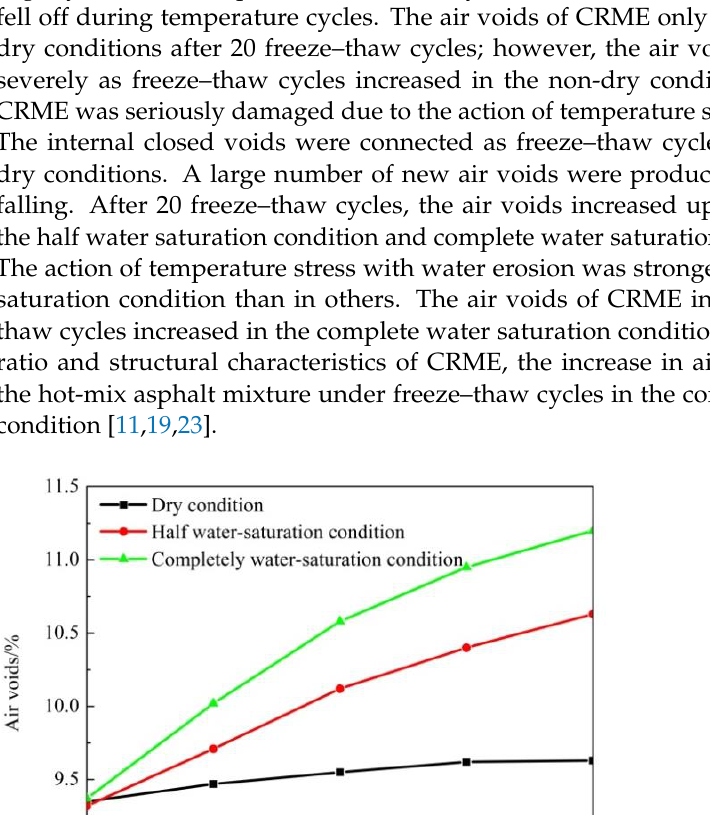
Figure 4. Shear strength under freeze – thaw cycles with different water saturation conditions. As schematically illustrated in Figure 5, the penetration depth of CRME increased as freeze – thaw cycles increased in different water saturation conditions. The penetration depth increased significantly with the water saturation ratio increasing. After 20 freeze –